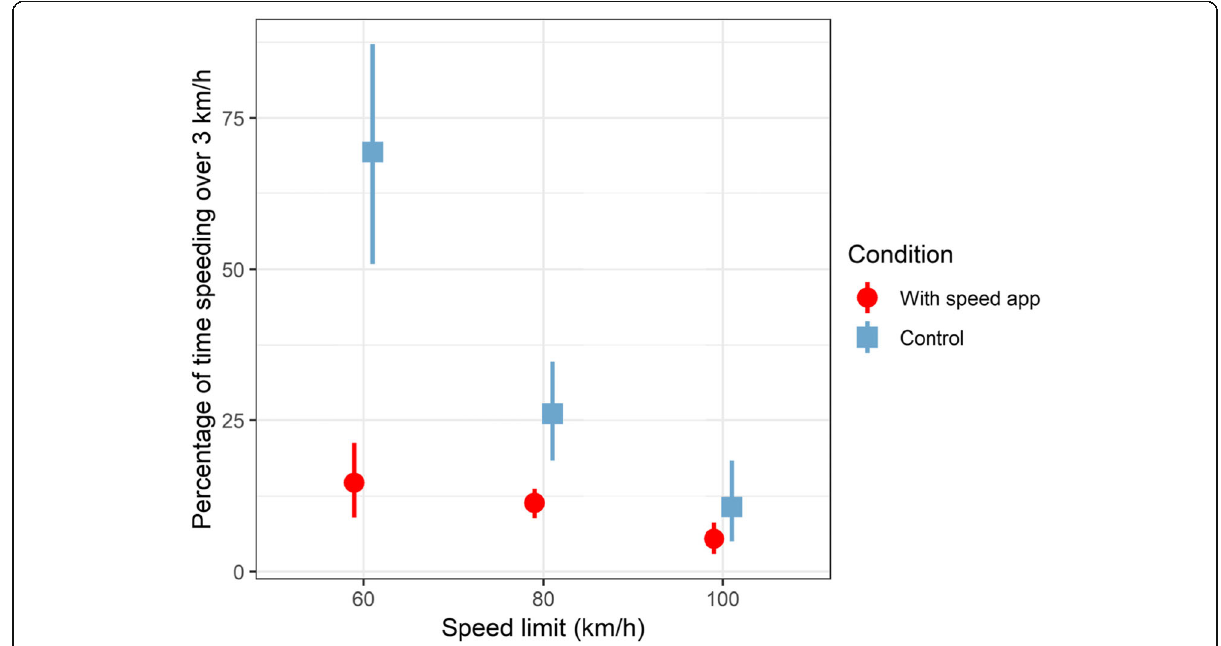
Fig. 3 Speeding as a function of speed limit and condition (with speed app vs.